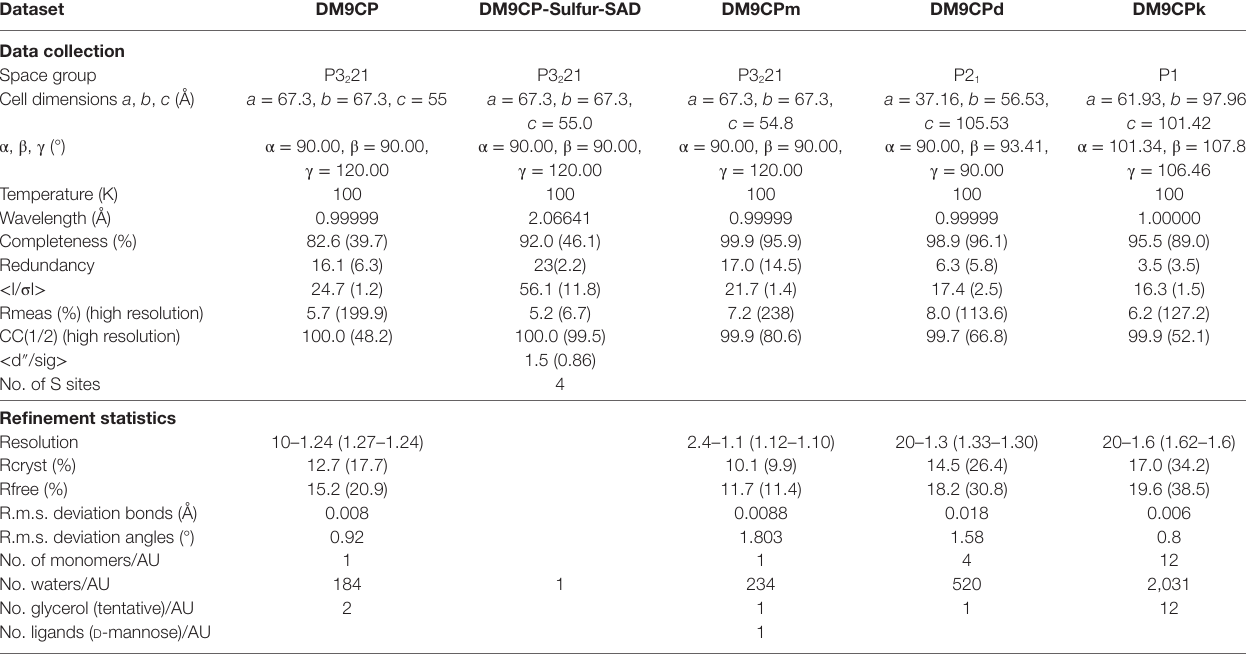
TaBle 3 | Data collection and refinement statistics.